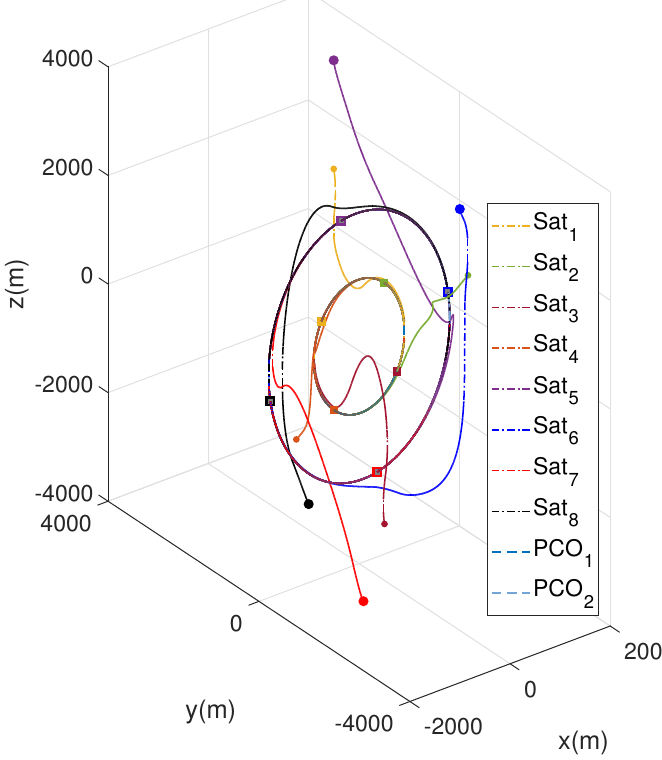
Figure 7. PDC law: Plot of 3D